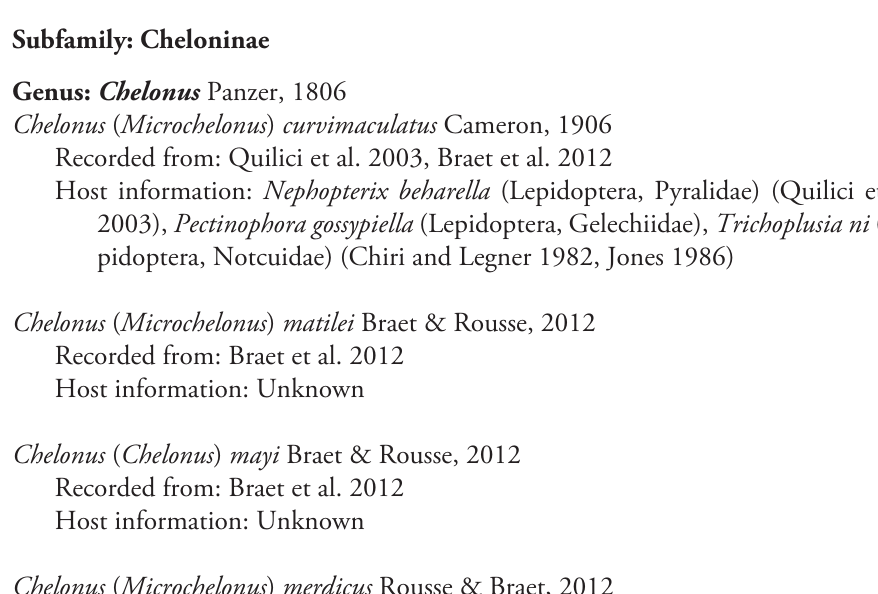
Chelonus ( Microchelonus ) merdicus Rousse & Braet, 2012 Recorded from: Braet et al. 2012 Host information: Unknown Chelonus sp. Recorded from: Quilici et al. 2003 Host information: Unknown